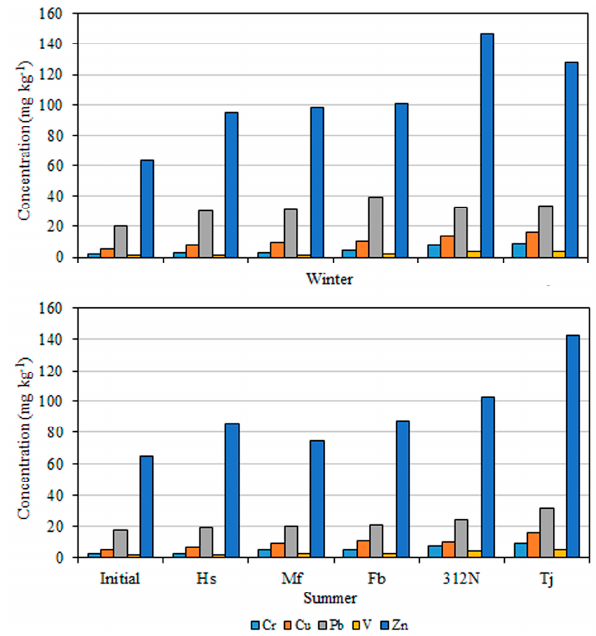
Figure 2. Average concentration of elements (mg · kg − 1 ) in Sphagnum junghuhnianum exposed to air in bags for 6 weeks at Huishan (Hs), Minfeng Road (Mf), Fengbin Road (Fb), 312 National Road (312N), and Tongjiang Road (Tj).